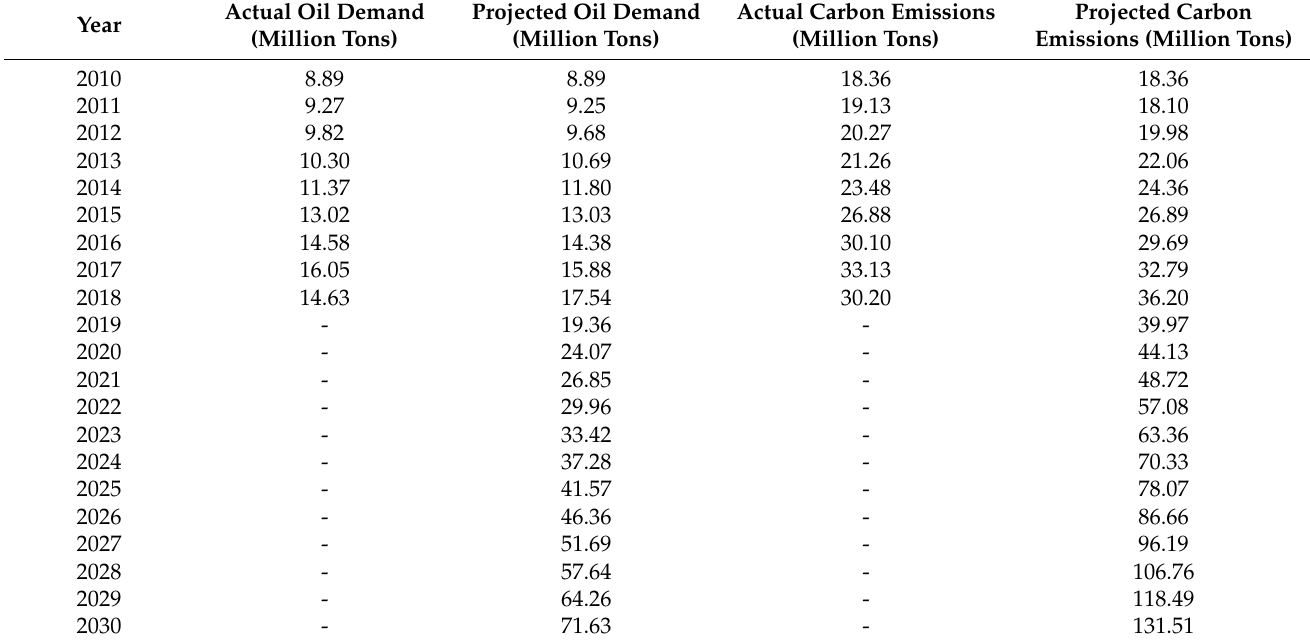
Table 1. Result of oil demand and carbon emissions